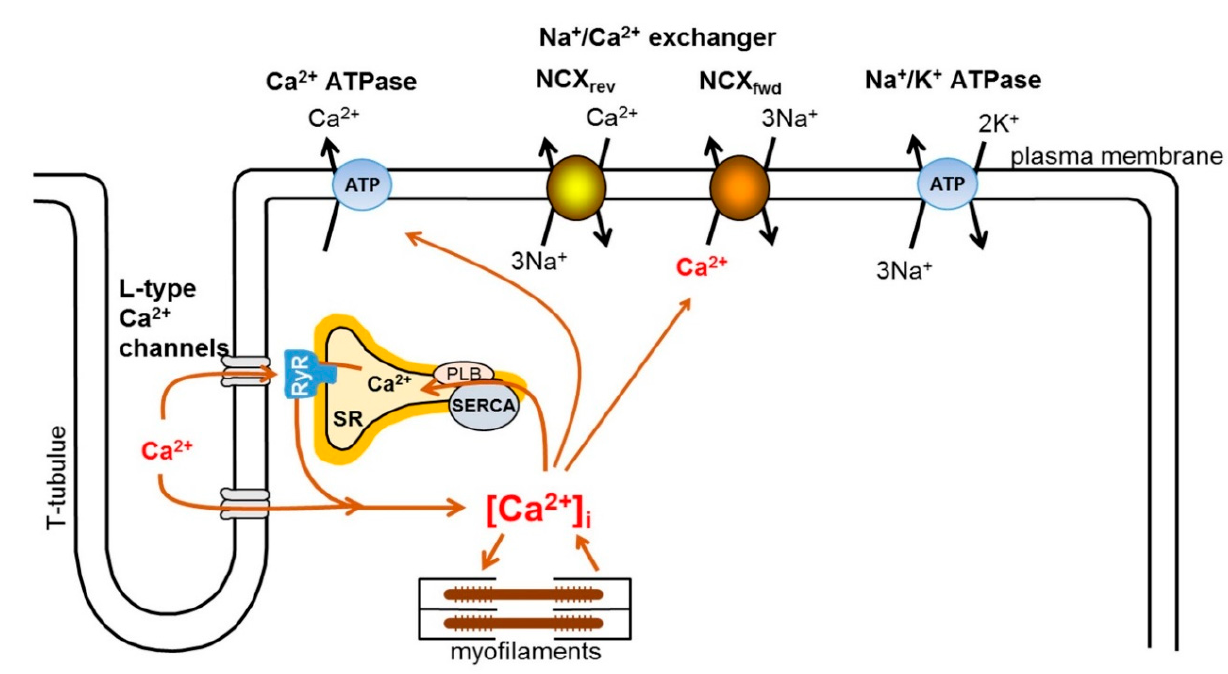
Figure 1. Schematic diagram of intracellular Ca 2+ handling in ventricular myocytes.